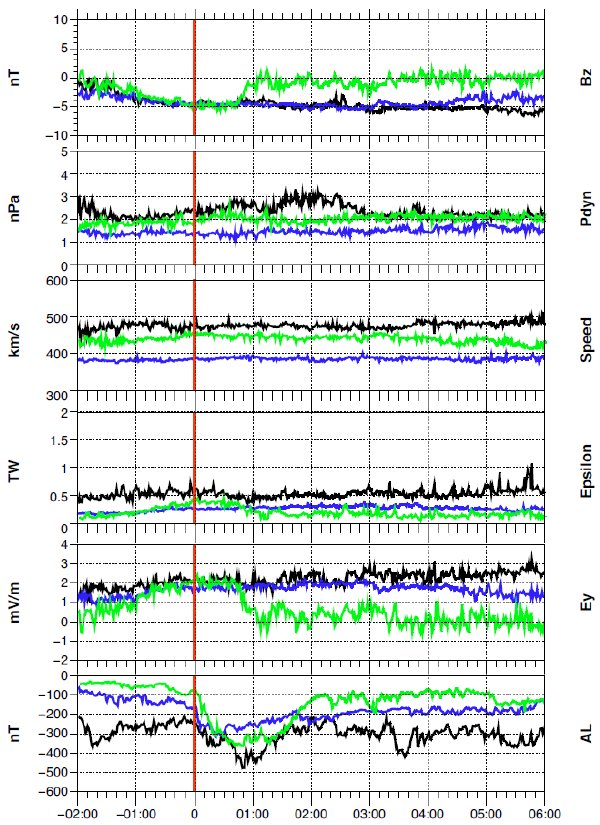
Fig. 6. Superposed epoch curves for the subsets of constant E Y of sawtooth events (black), SMC periods (blue), and isolated sub- storms (green). The panels from top to bottom are: IMF B Z , solar wind dynamic pressure, solar wind speed, epsilon parameter, solar wind motional electric field, and AL index.